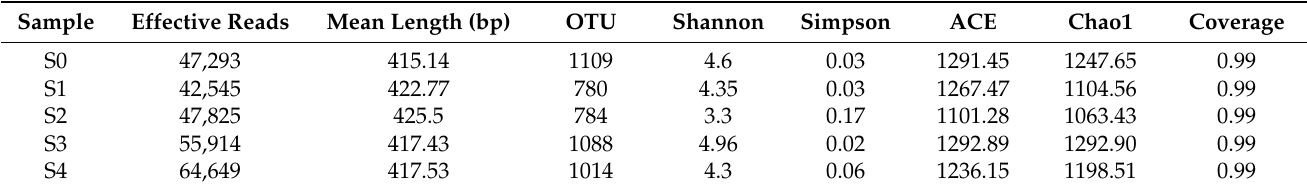
Table 2. Microbial diversity of all sludge samples